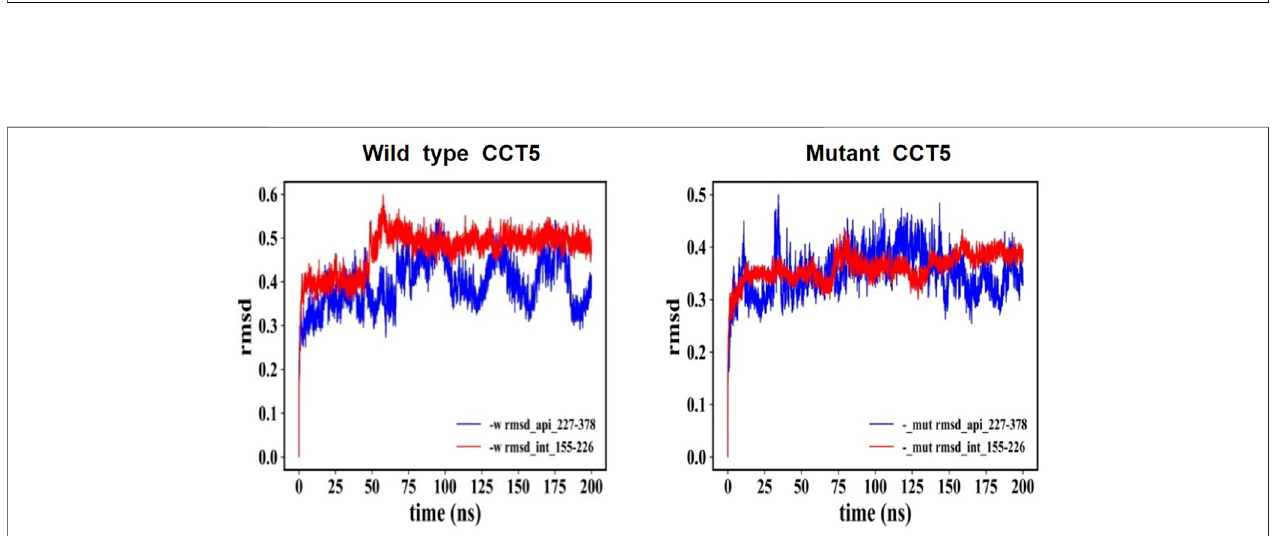
FIGURE12| RMSD:Comparisonofnucleotide-freeCCT5,wildtypevs.mutant.RMSDoftheentiremolecules,wildtypeandmutantCCT5,weredetermined,and theoutputswereexaminedinvariousways.Here,wepresentthecomparisonofthepartsoftheoutputspertainingtotheN-terminalsegmentoftheintermediatedomain and totheapicaldomain, whichillustrates thedifferencebetweenthewildtypeandthemutantmolecules.Leftpanel:Wildtypemoleculeapicaldomain, blue; N-terminal segmentofintermediatedomain,red.Rightpanel:Mutantmoleculeapicaldomain, blue;N-terminalsegmentofintermediate domain, red.TheRMSDvaluesreveal differences between the two molecules and instability of the apical domain of the mutant. Similar trends were shown when ADP and ATP bound molecules were examined, although in the ATP-bound molecules the differences in instability of the mutant with regard to the wild-type molecule were less marked (data not shown).